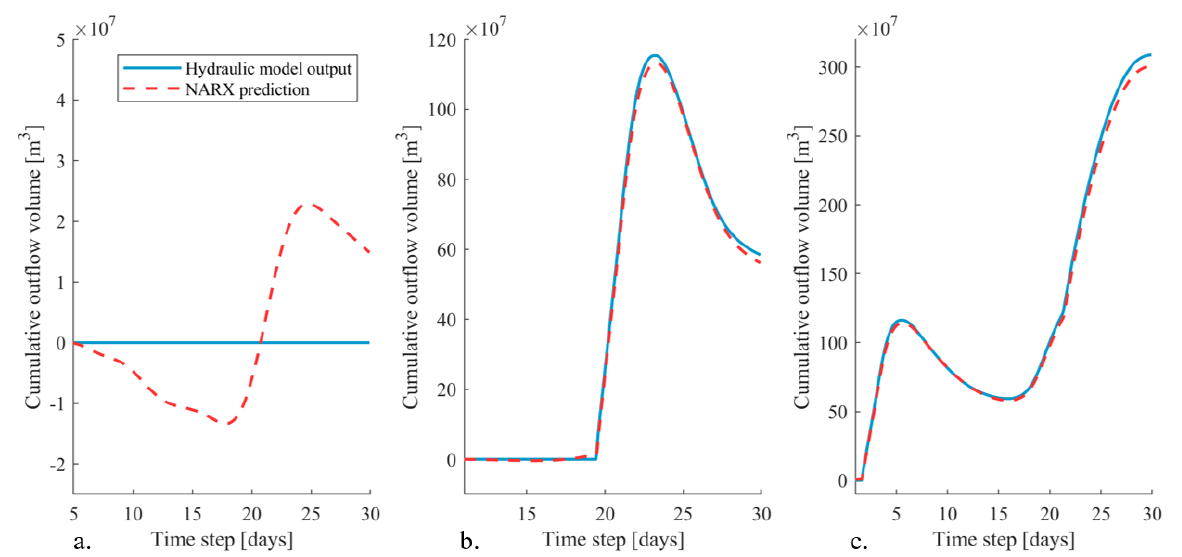
Figure 11. ( a – c ) The cumulative outflow volume over time for the upstream breach location predicted by the hydraulic model and the NARX network as a result of the upstream discharge waves presented in Figure 8.